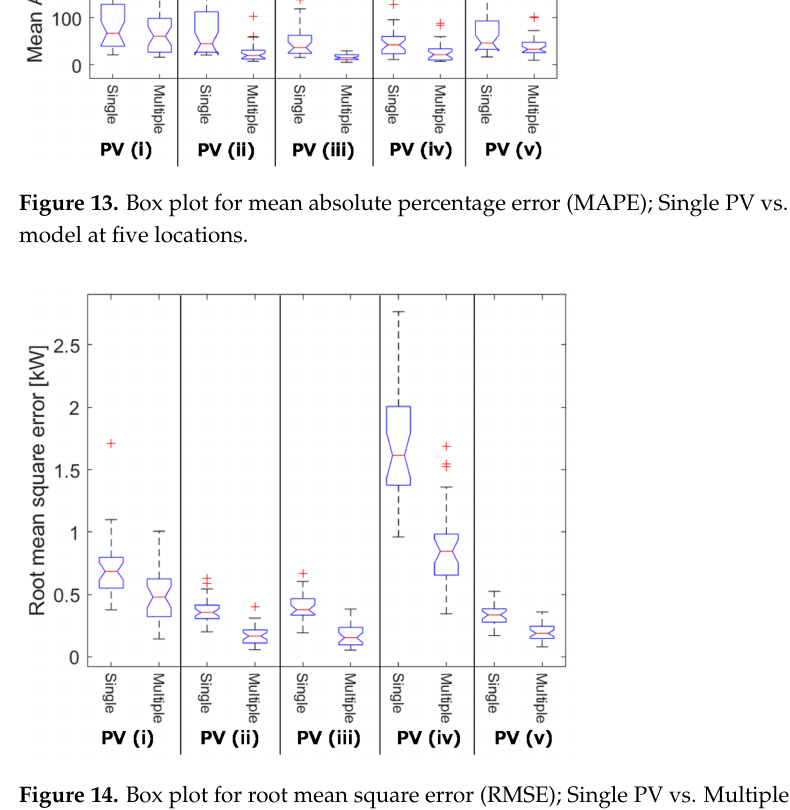
Figure 14. Box plot for root mean square error (RMSE); Single PV vs. Multiple PV forecast model at five